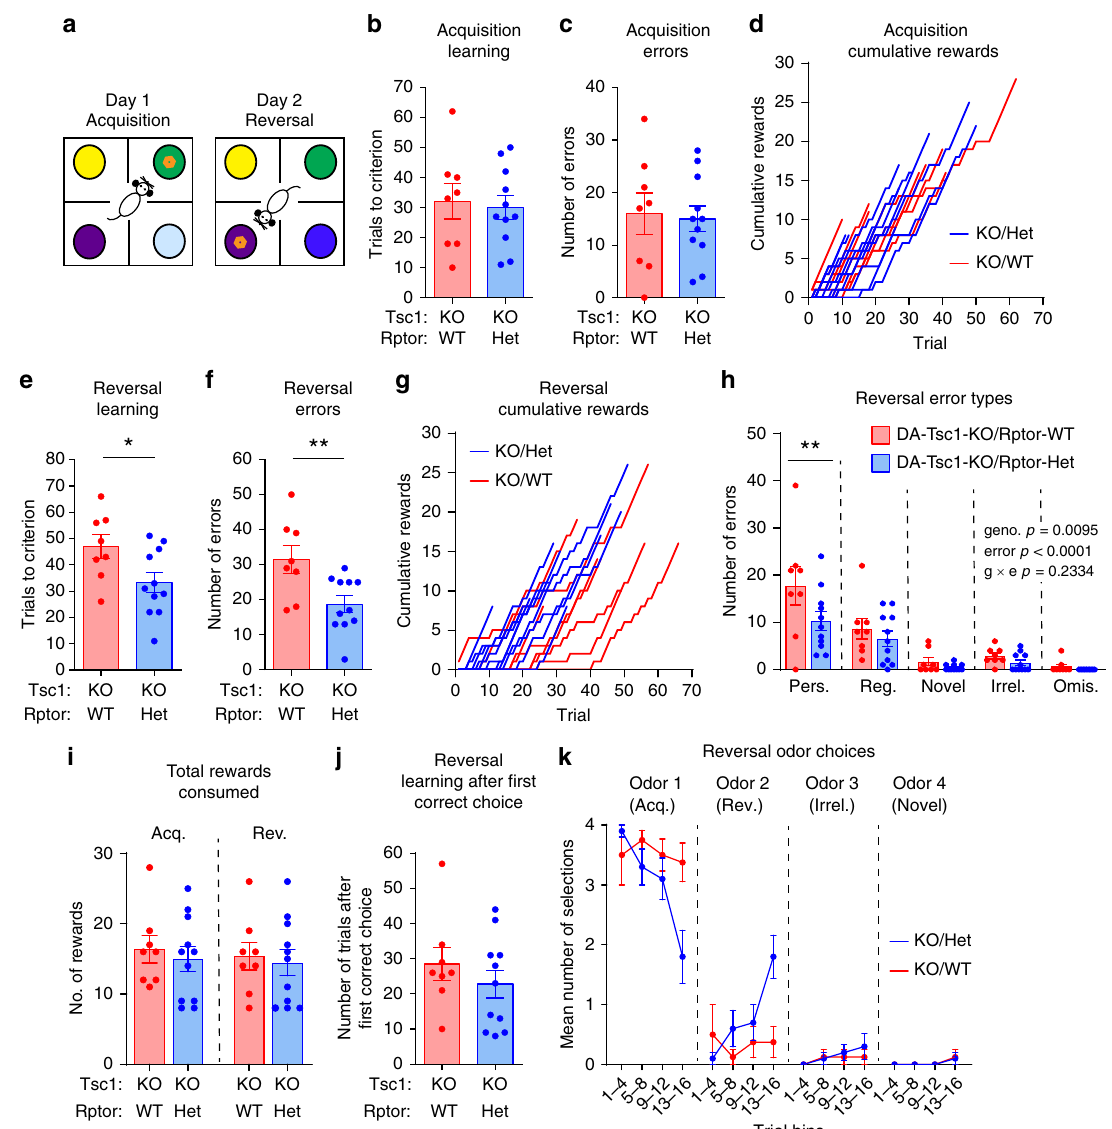
Fig. 9 Heterozygous Rptor deletion increases cognitive fl exibility in DA-Tsc1-KO mice. a Schematic of the four-choice odor-based reversal learning task. b , c Mean± SEM number of trials taken to reach criterion (eight out of ten correct) during acquisition learning ( b ) and total errors made during acquisition learning ( c ) in the four-choice test. d Step function cumulative reward plot for individual animals during acquisition learning. e, f Mean ± SEM number of trials taken to reach criterion (eight out of ten correct) during reversal learning ( e , * p = 0.0338) and total errors made during reversal learning ( f , ** p = 0.0095), unpaired, two-tailed t tests. g Step function cumulative reward plot for individual animals during reversal learning. h Analysis of different error types during reversal learning. Bars represent mean ± SEM number of perseverative (Pers.), regressive (Reg.), novel, irrelevant (Irrel.), or omission (Omis.) errors for mice of each genotype. Two-way ANOVA p values are shown. ** p = 0.0072, Sidak ’ s multiple comparisons test. i Mean ± SEM total number of rewards obtained and consumed during acquisition (Acq.) and reversal (Rev.) learning. j Mean± SEM and number of trials to reach criterion (eight out of ten correct) during reversal learning after the fi rst correct selection of the newly rewarded odor. k Mean± SEM number of odor selections in bins of four trials during reversal learning. Odor 1 is the odor rewarded during acquisition learning and odor 2 is the odor rewarded during reversal learning ( 1 DA-Tsc1- KO/Rptor-Het mouse was excluded from this plot as it reached criterion in <16 trials). For all panels, DA-Tsc1-KO/Rptor-WT: n = 8 male mice and DA- Tsc1-KO/Rptor-Het: n = 11 male mice. For all bar graphs, dots represent values for individual mice. See Supplementary Table 5 for p values for all behavior tests. Source data are provided as a Source Data fi